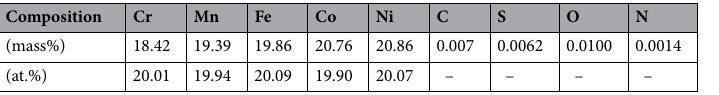
Table 1. Composition of CrMnFeCoNi